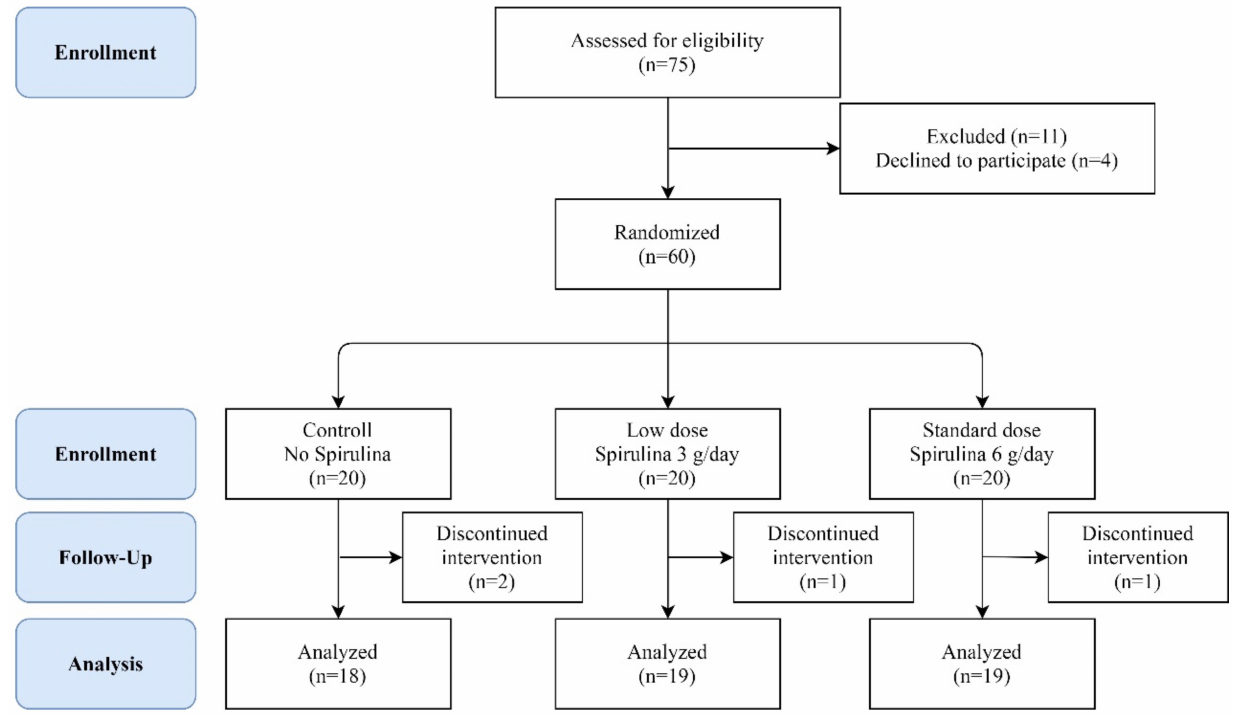
Figure 1. Flowchart for enrollment. Schemes follow another format. A total of 350 patients were enrolled into the initial evaluation of the study. Finally, 60 CHB patients were randomized into three groups: control and oral Arthrospira at 3 or 6 g daily add-on therapy groups. Four patients decided not to continue and left the trial